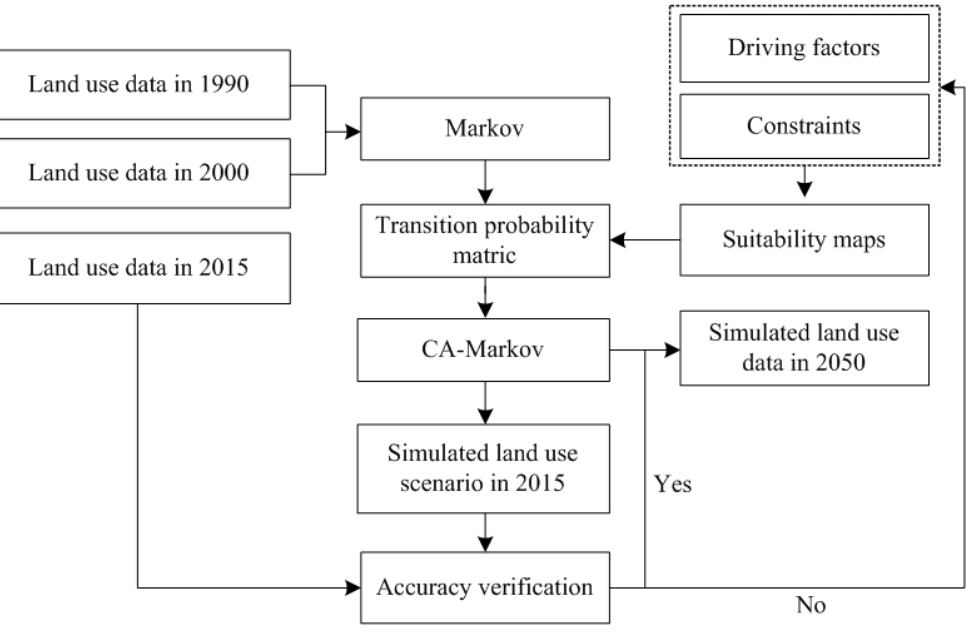
Figure 3. Framework of land-use simulation.